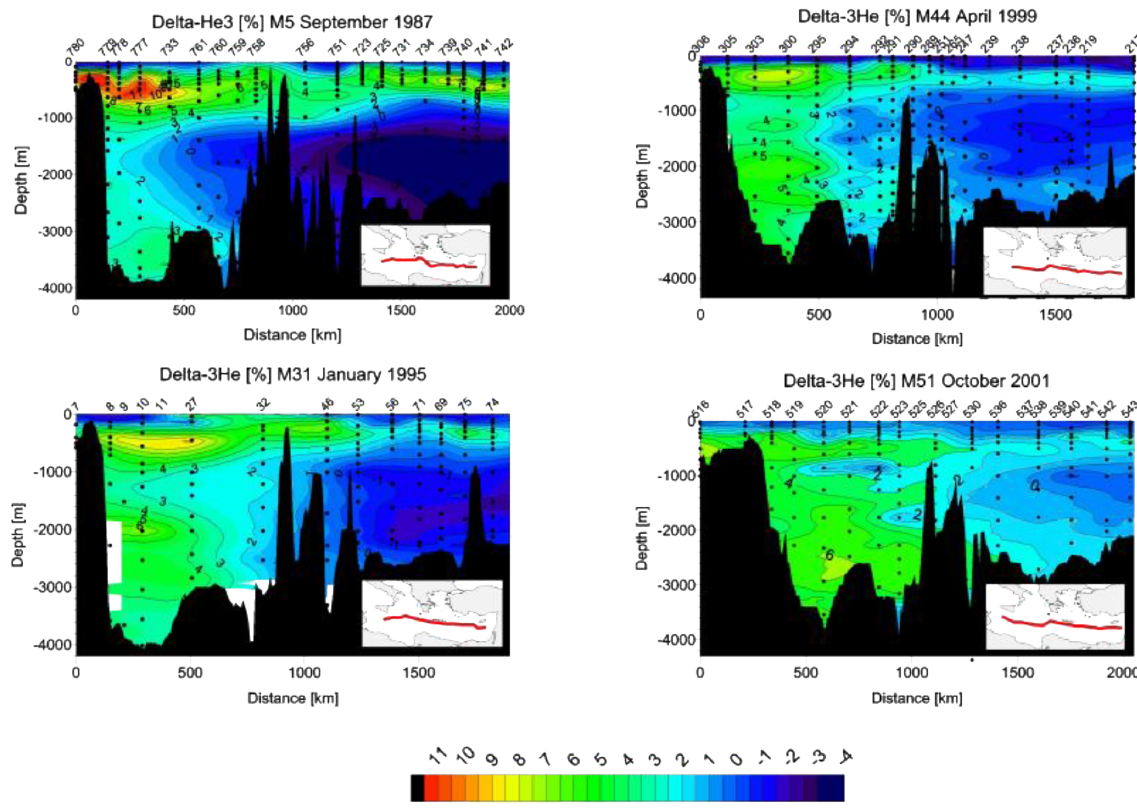
Figure 2. δ 3 He sections of the Meteor cruises in 1987, 1995, 1999 and 2001. Numbers on top are station numbers, observations are indicated by dots, and the actual sections are shown in the inset maps. Isolines are by objective mapping (reproduced from Roether et al.,